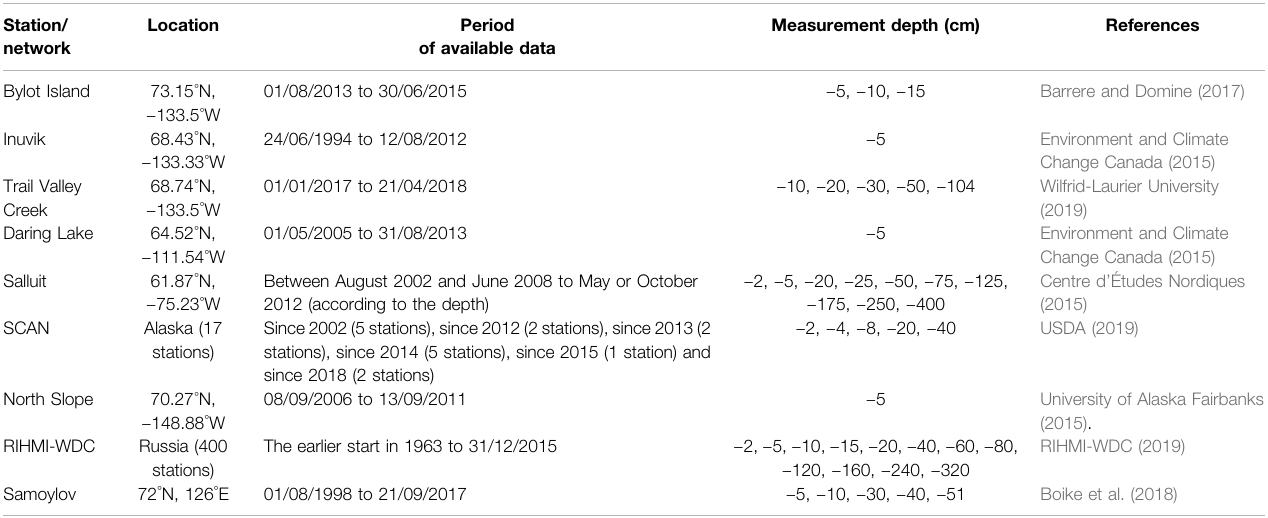
TABLE 2 | Global soil temperature datasets description. Station/